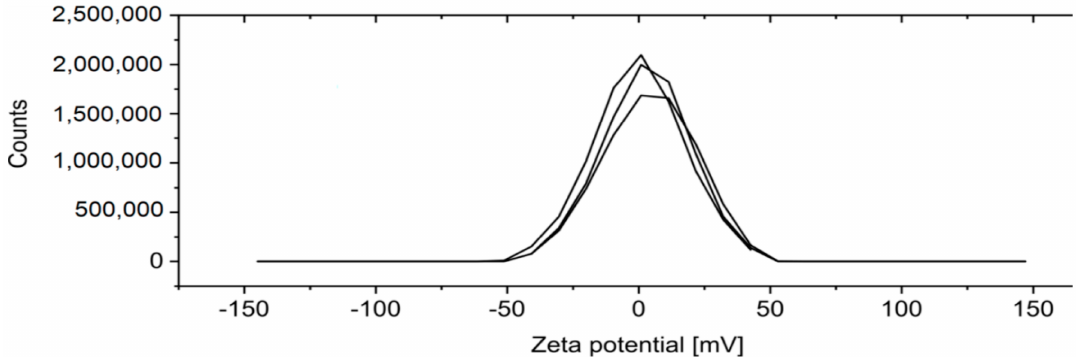
Figure 5. Zeta potential distribution of Fe 3 O 4 nanoparticles. Three repetitions were conducted in toluene, 25 °C.